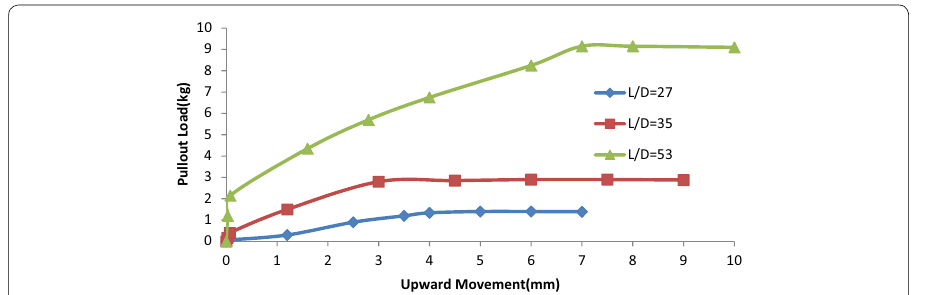
Fig. 17 Pullout load-upward movement curves for helical pile with double helix (dh